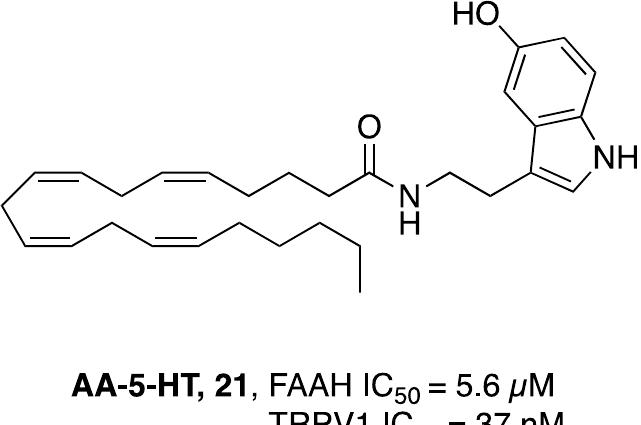
Figure 7. Chemical structure and IC 50 values of AA-5-HT (21), against FAAH and TRPV1.